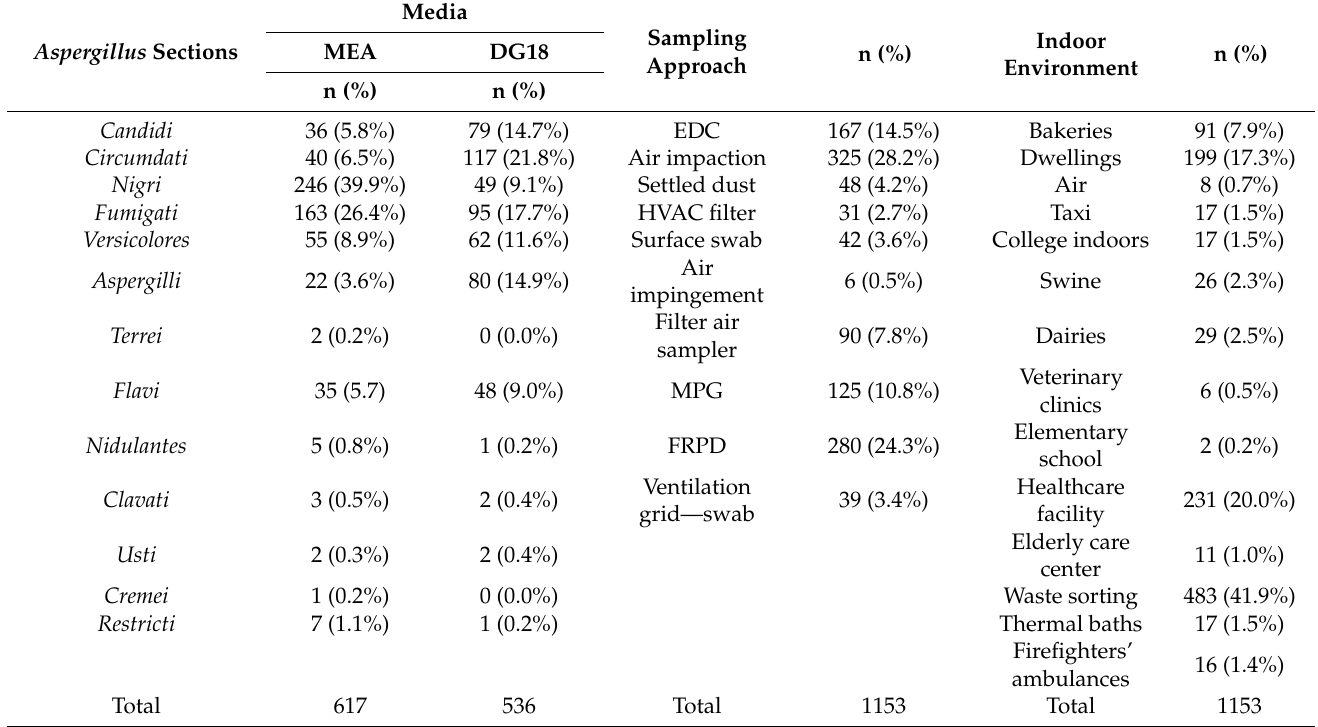
Table 2. Frequency distribution of the detected Aspergillus by sections, sampling method, and indoor environment.